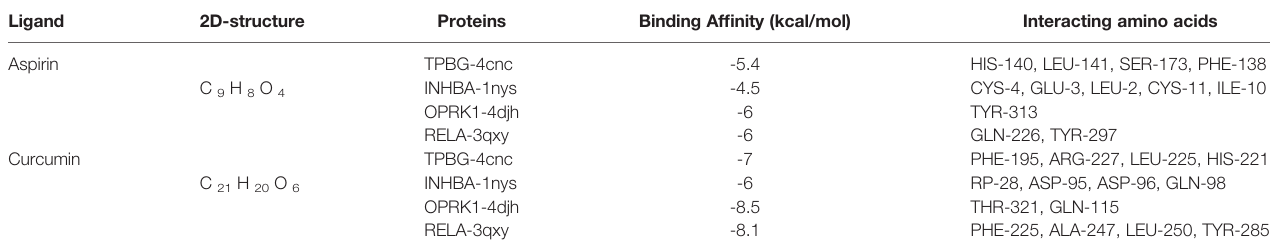
TABLE 2 | The docking score of aspirin and curcumin to TPBG-4cnc\ INHBA-1nys\ OPRK1-4djh\RELA-3qxy (RMSD: 0.00).